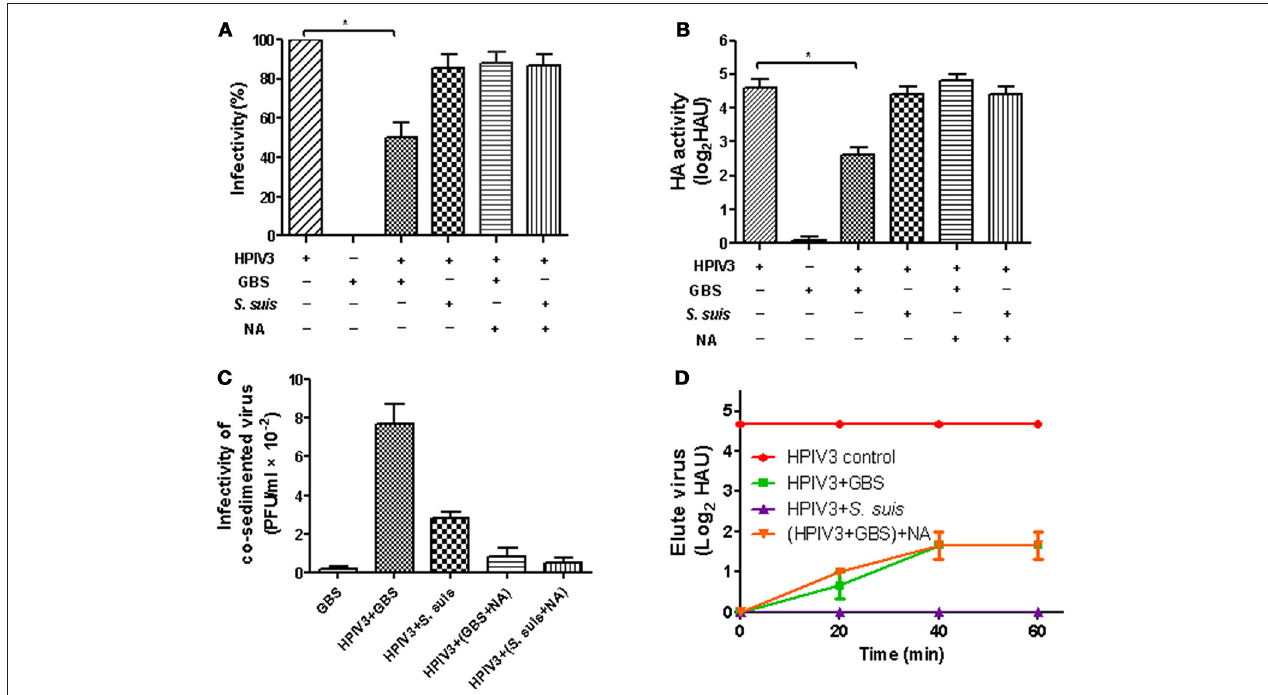
FIGURE 1 | HA activity and infectivity of HPIV3 after co-sedimention with GBS or S. suis. After incubation of HPIV3 with GBS, NA-pretreated GBS or S. suis , the bacteria were pelleted by low-speed centrifugation. The supernatants were analyzed for infectivity (A) by plaque titration on HEp-2 cells or for HA activity (B) using guinea pig erythrocytes. The pellet fractions (C) were analyzed for the presence of infectious viruses by plaque titration on HEp-2 cells. In (D) , pelleted bacteria were resuspended in PBS with or without NA and incubated for 1h at 37 ◦ C. At the times indicated, aliquots were collected for HA titration to detect the eluted virus. Statistical significance was determined with one-way ANOVA, * P < 0.05 .